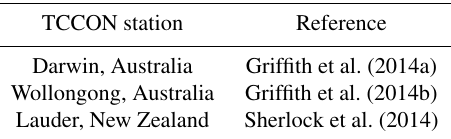
Table 2. Reference of the TCCON stations used in this work for evaluation of our inverse model system.